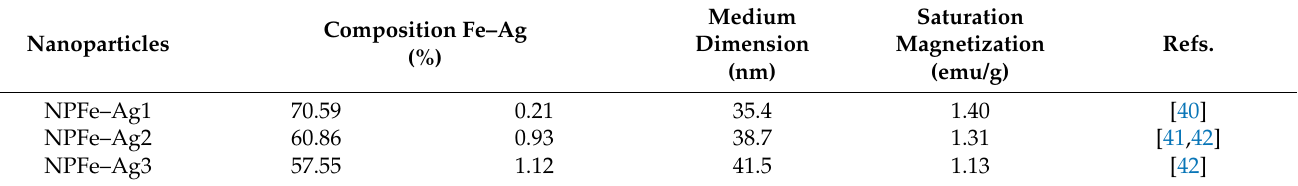
Table 2. The used magnetic nanoparticles’ characteristics.